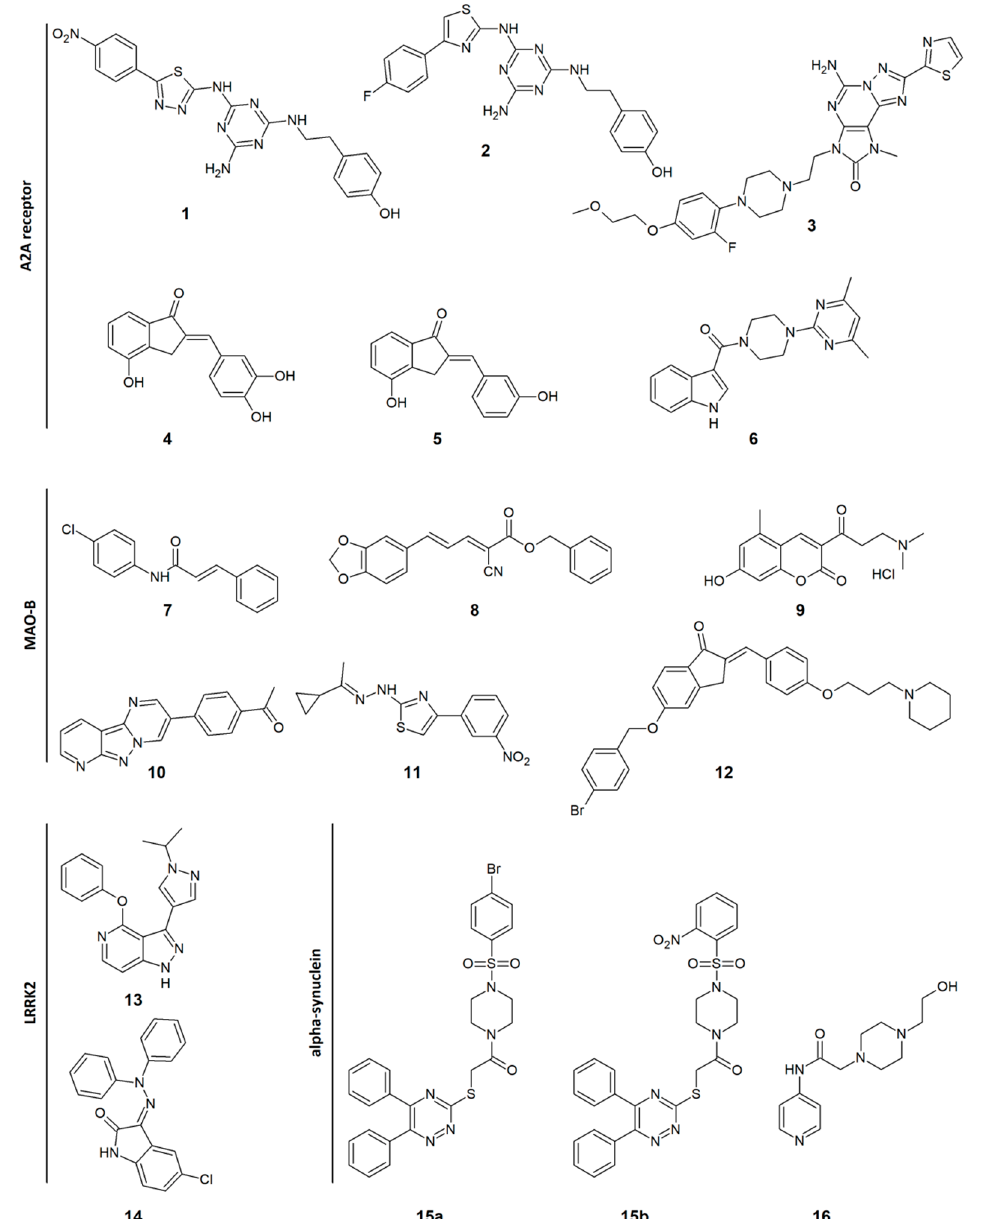
Figure 2. Chemical formulas of exemplary novel agents for potential application in the treatment of Parkinson’s disease. A2A—Adenosine A 2A ; MAO-B—Monoamine oxidase B; LRRK2—Leucine-rich repeat kinase 2. Table 1. Affinities and potencies of novel compounds at certain molecular targets (numeration according to Figure 2).